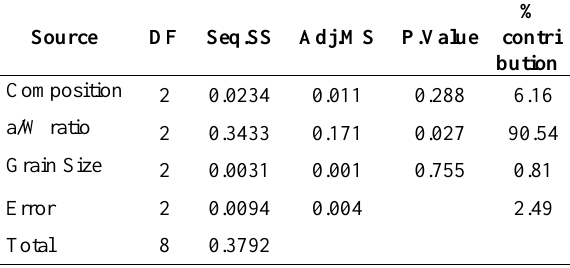
Table 4(a). Analysis of variance for Load carrying